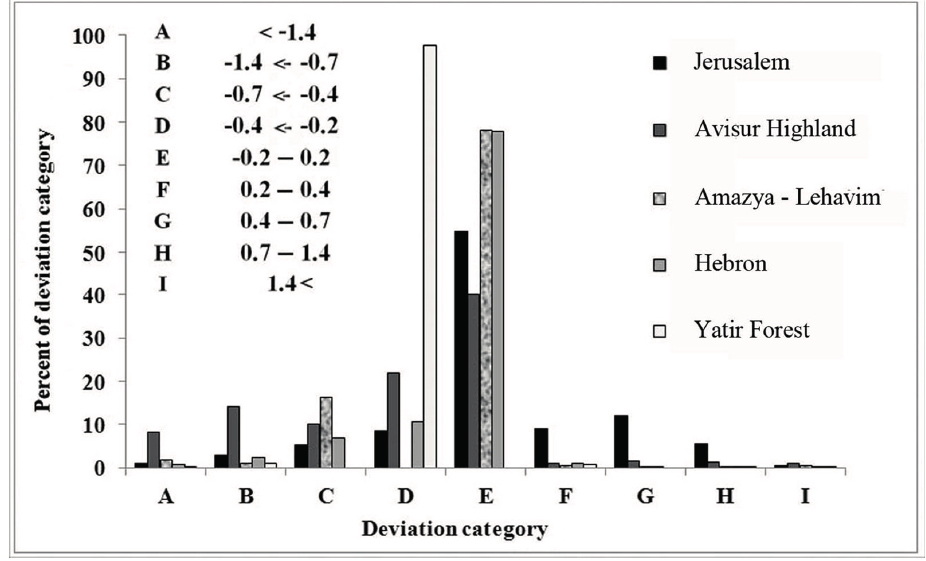
Figure 13. Percentage area for different deviation categories as derived from detailed analysis units in the Jerusalem Mountains, the Avisur Highlands, Amazya-Lehavim, Hebron and Yatir